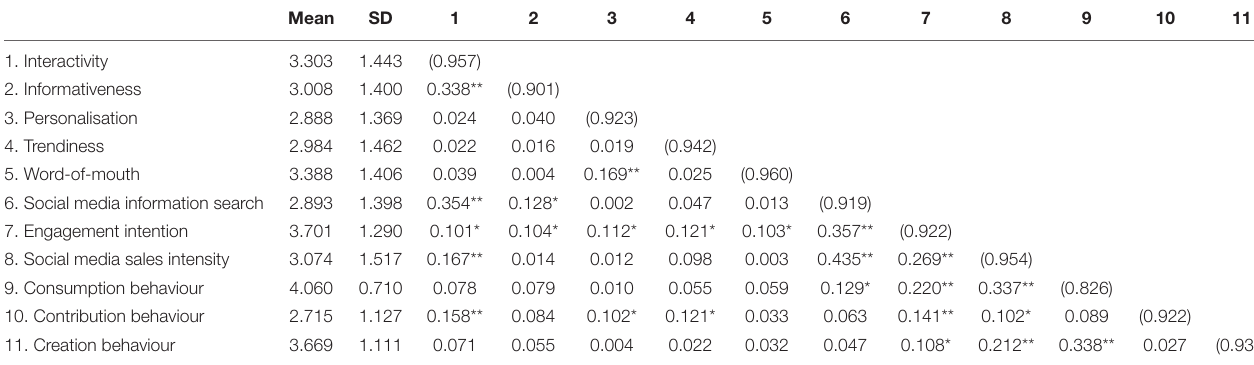
TABLE 1 | Descriptive statistics, reliabilities, and correlation matrix.